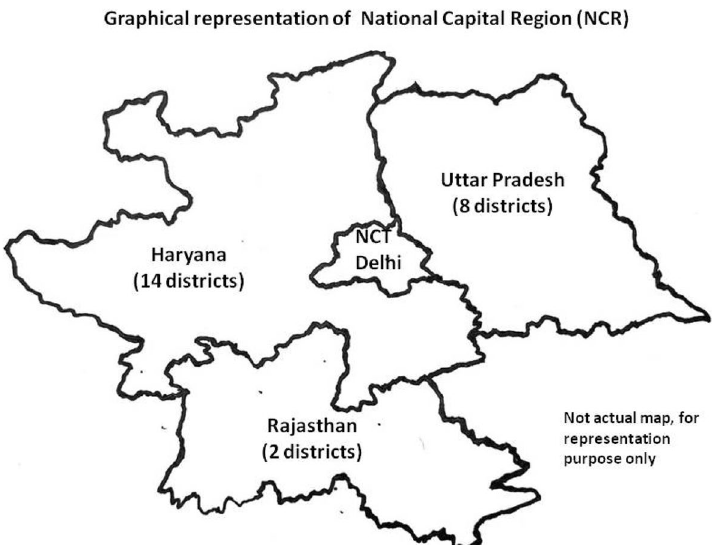
Fig. 1 Graphical representation of National Capital Region (NCR) which includes whole of National Capital Territory (NCT) of Delhi and 24 districts in three neighbouring states of Haryana, Uttar Pradesh and